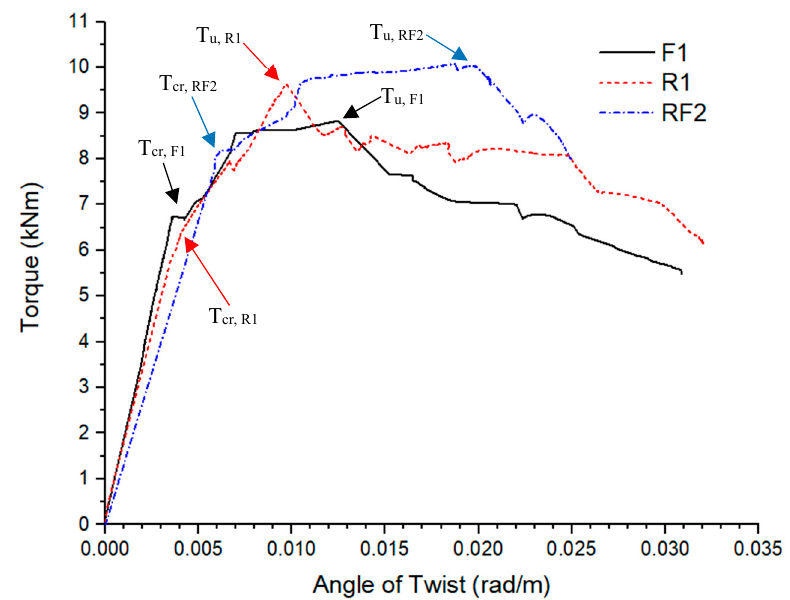
Figure 6. Comparison of the torque versus angle of rotation of purely fibre reinforcement, conventional reinforcement and the hybrid reinforcement of both fibres and conventional reinforcements.